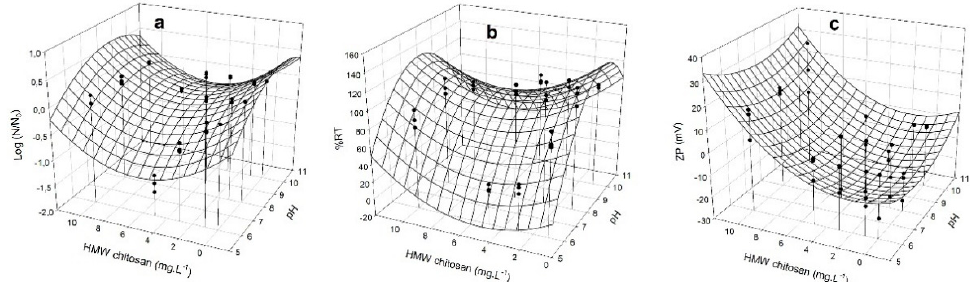
Figure 4. Response surface plot for M. aeruginosa PCC 7806 of: ( a ) log (N/N 0 ), where N and N 0 are the number of cells/mL − 1 after and before the treatment, respectively; ( b ) %RT removal; and ( c ) ZP of the clarified zone, as a function of different concentrations of HMW chitosan (mg L − 1 ) and pHs. (•) experimental measurements.